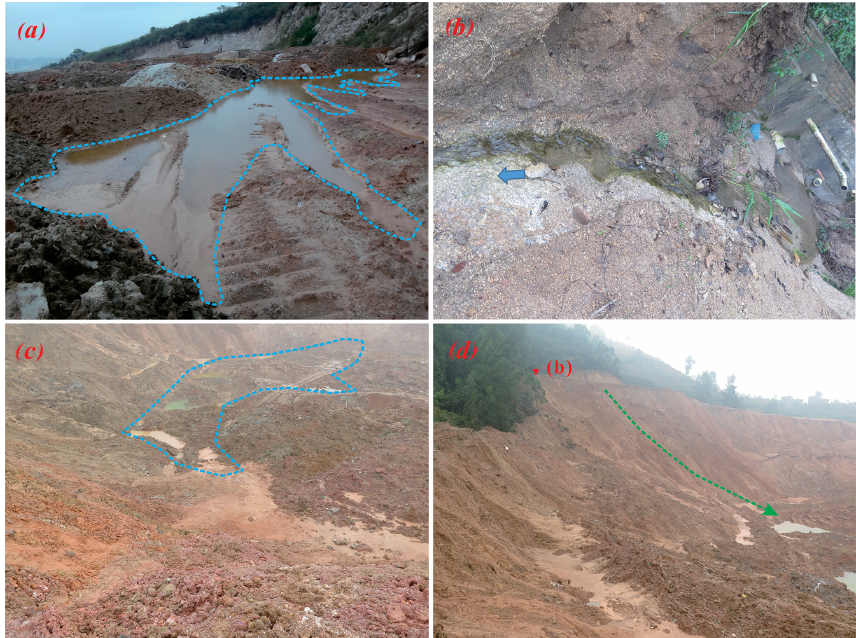
Figure 6. (a) Groundwater overflow in the rock fissures near the flowslide crown; (b) water accumulation in the flowslide crown; (c) water accumulation in the source area; (d) surface runoff and infiltration contributed to groundwater